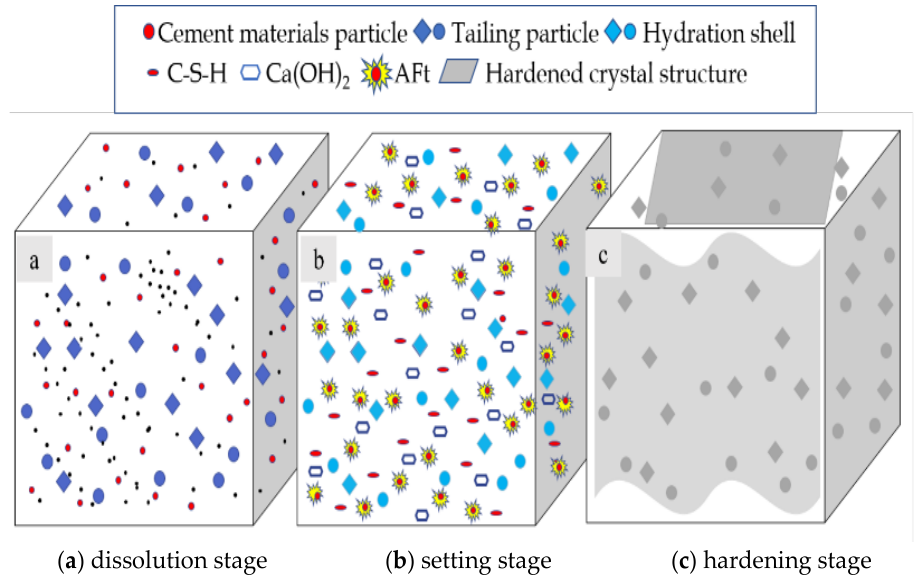
Figure 10. Schematic diagram of hydration feature description model.